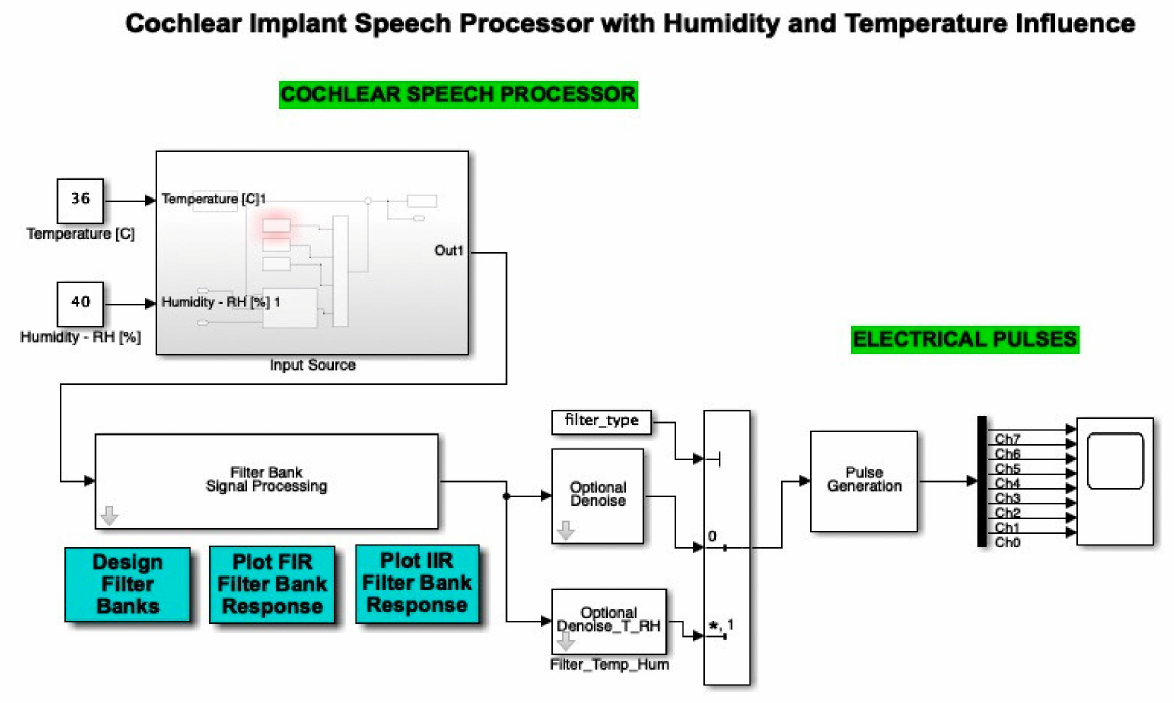
Figure 9. Simulink diagram of the modified input source block in the presence of the temperature and humidity influence. (*: value at the address of